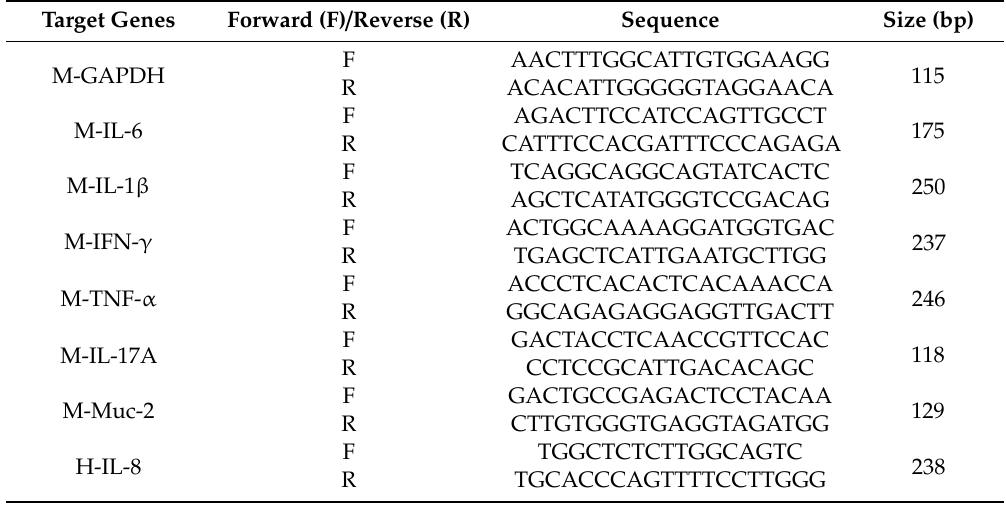
Table 1. Primer sequences used for real-time